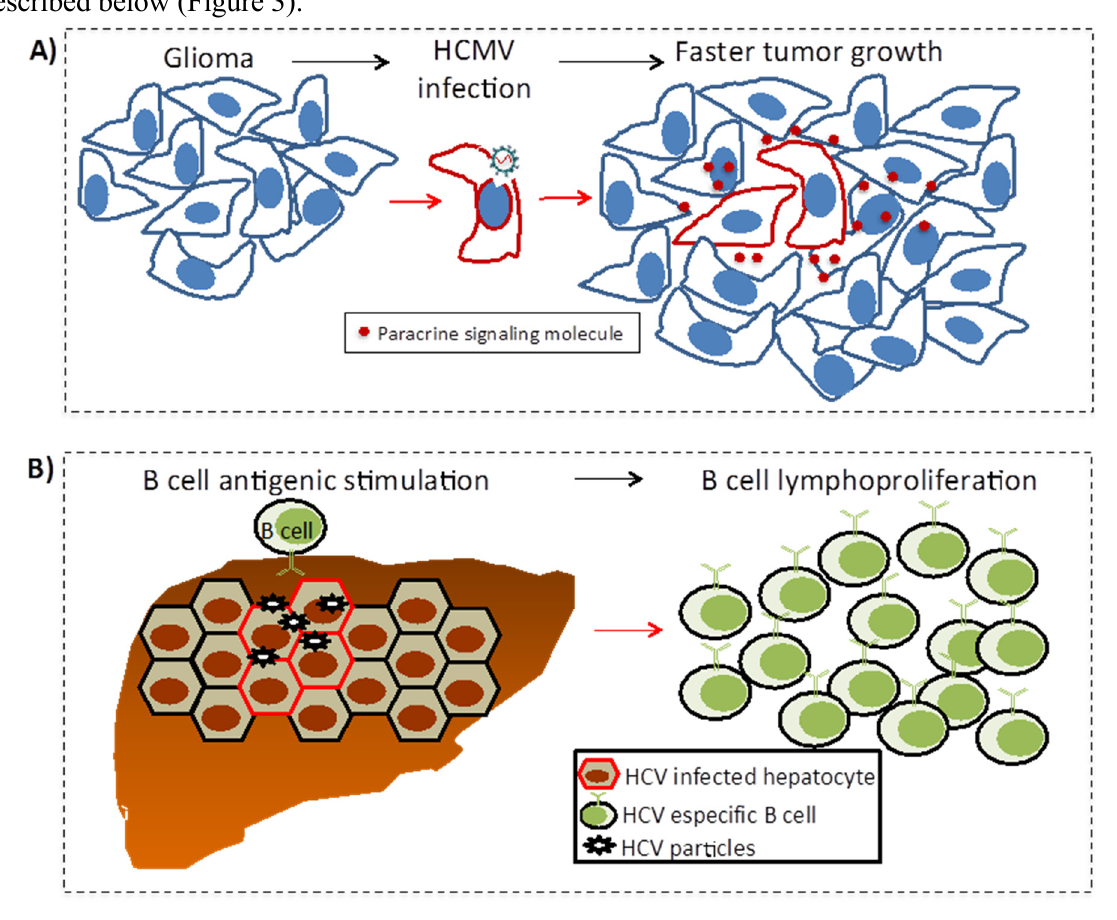
Figure 3. Other indirect mechanisms: Oncomodulation ( A ) and chronic antigen-driven lymphoproliferation ( B ). ( A ) In oncomodulation HCMV does not participate in the